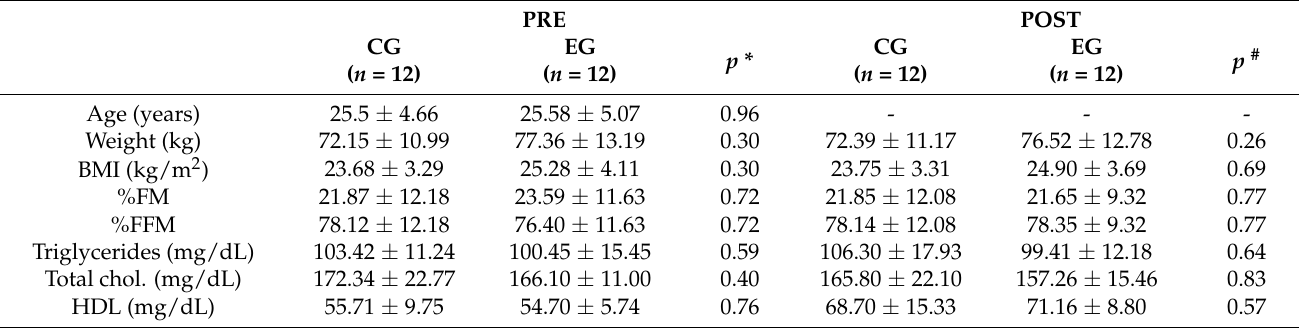
Table 1. Clinical, anthropometric and cardiorespiratory fitness variables before and after 10 weeks of control and exercise